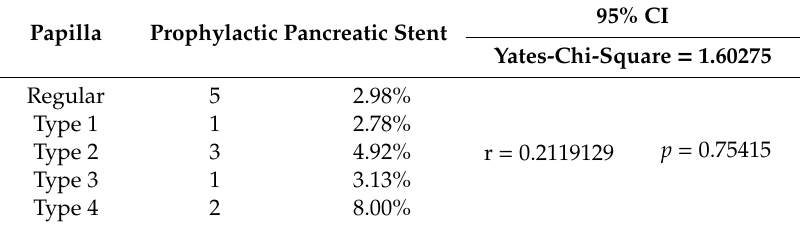
Table 5. Distribution of pancreatic stent insertion among di ff erent types of